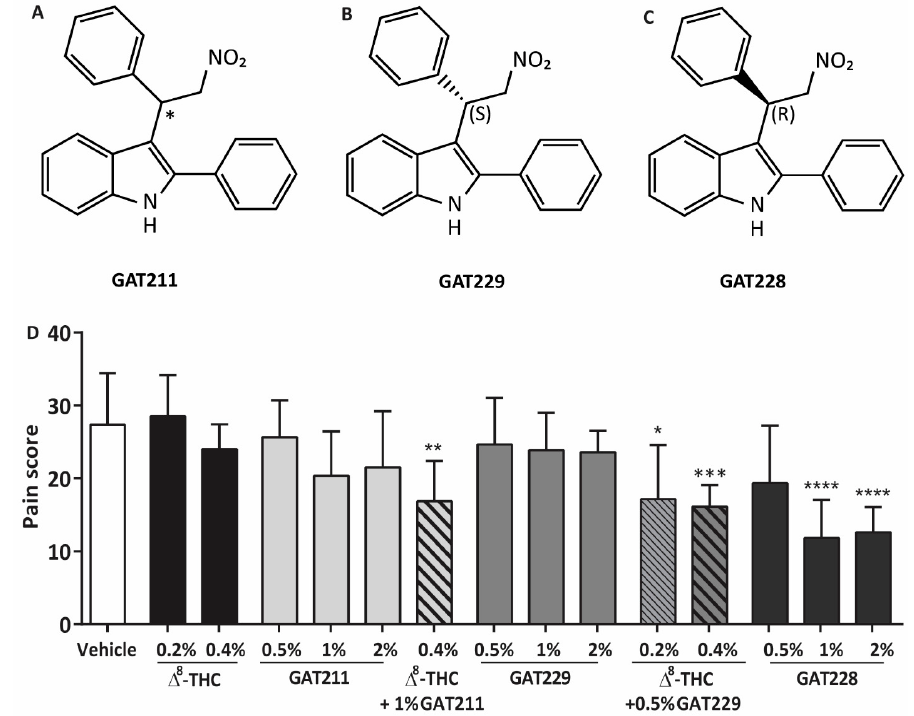
Figure 1. The structure of ( A ) GAT211, the ( B ) R -( + )-enantiomer GAT228 and the ( C ) S -( − )-enantiomer GAT229 [34]. ( D ) Dose-response for GAT211 (0.5–2.0%, n = 6 per group), GAT229 (0.5–2%, n = 6